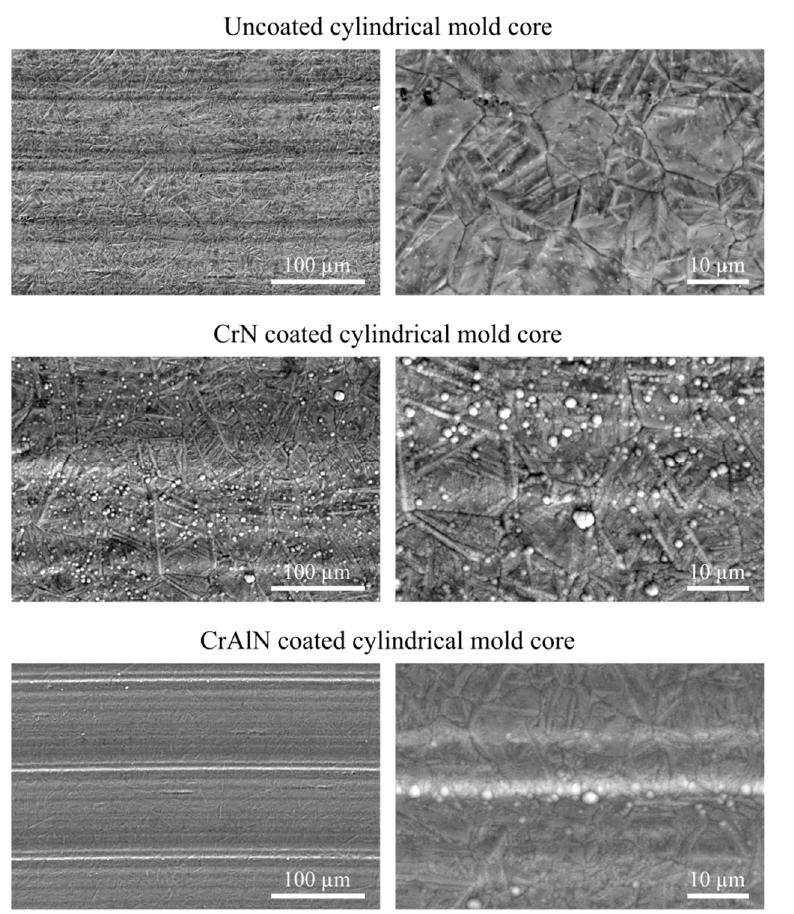
Figure 6. SEM micrographs of the core’s surfaces with a cylindrical geometry.